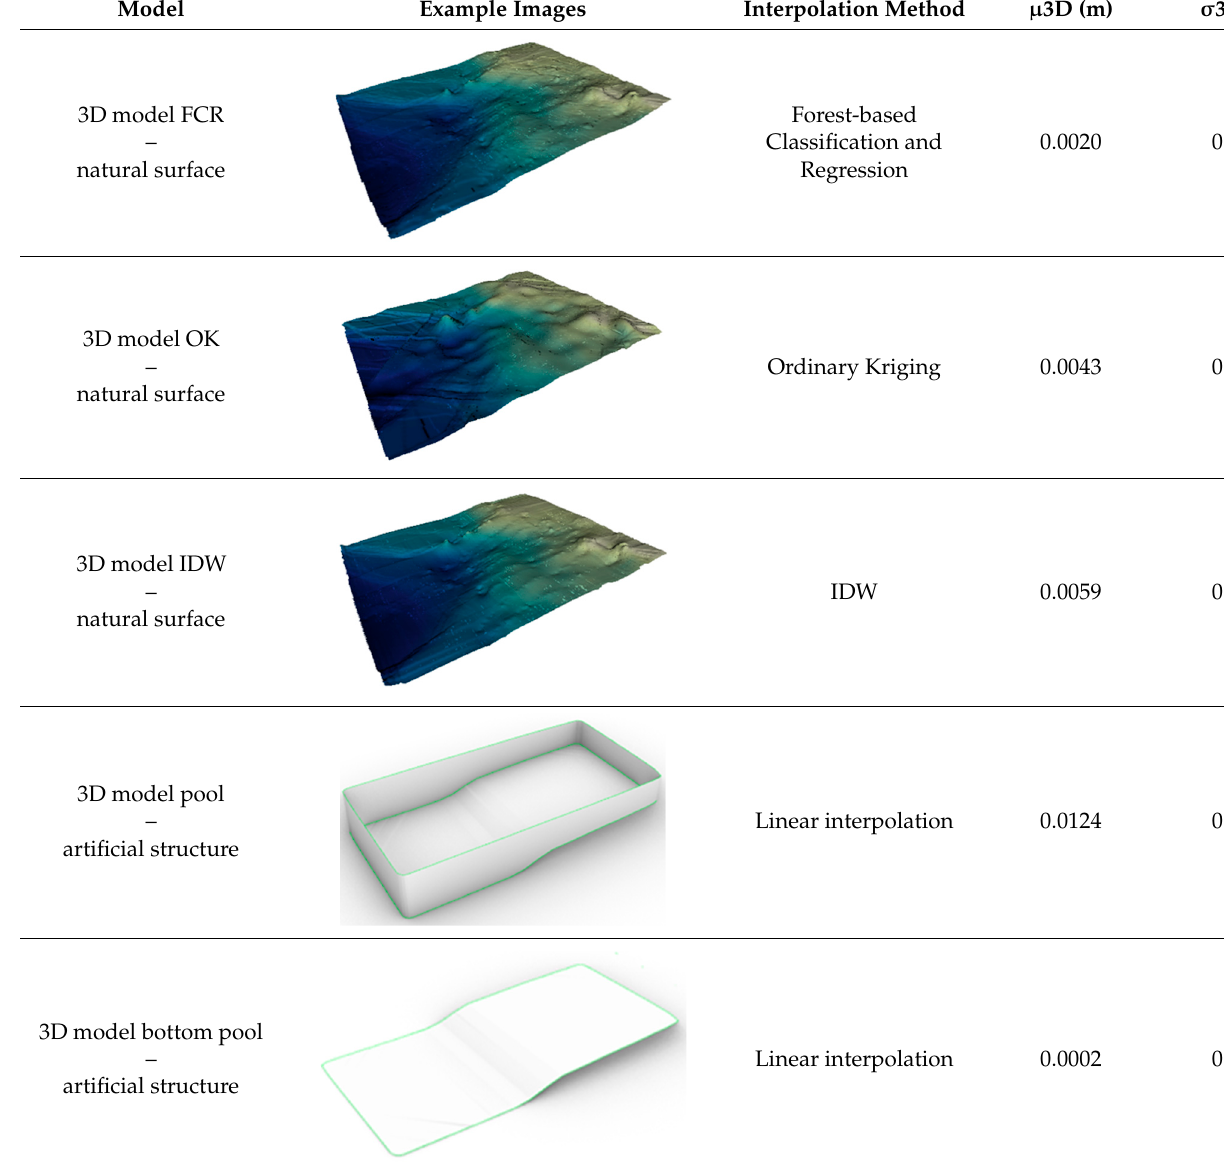
To evaluate the accuracy and precision of the 3D models produced, a comparison based on Cloud-To-Mesh (C2M) distance was performed in CloudCompare (Table 14). Table 14. Mean and standard deviation values of C2M distance of seabed and pool models.